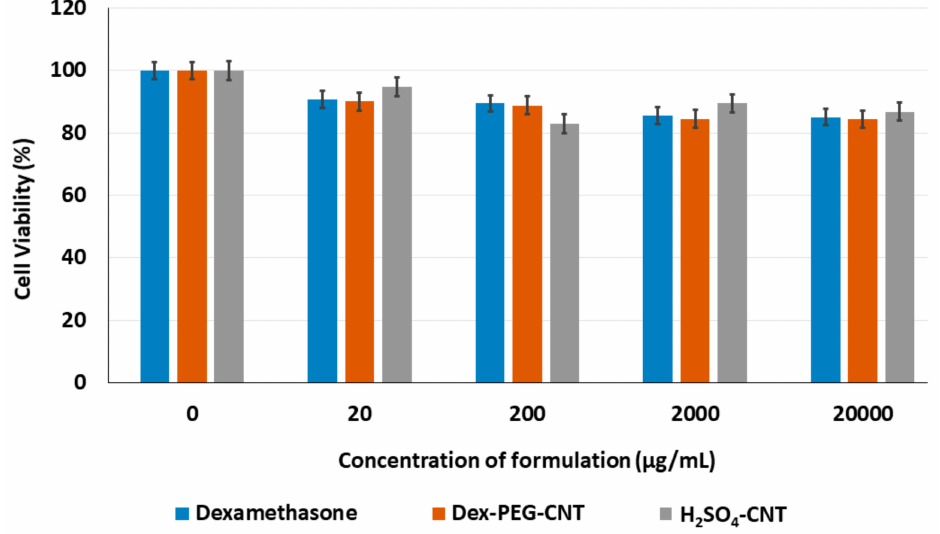
Figure 8. Cell viability following incubation with various concentrations of functionalized carbon nanotubes. H 2 SO 4 -MWCNTs were used as they are highly dispersible and hydrophilic. Blue column = free dexamethasone, brown column = equivalent dexamethasone concentration coupled to PEGylated MWCNTs and grey column for sulfonitric acid functionalized MWCNTs without dexamethasone. Concentrations of each formulation expressed as µ g/mL from 0 to